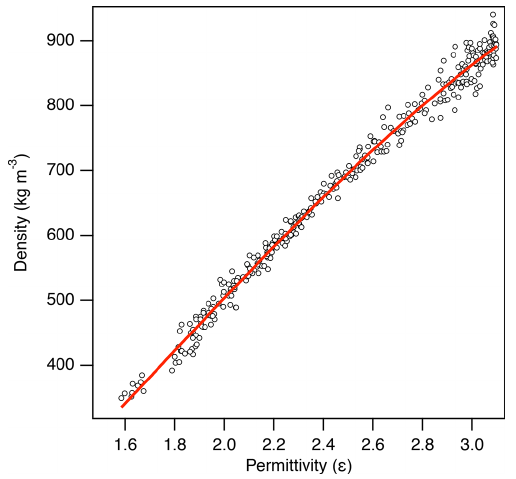
Figure A1. Scatter plot of the permittivity and bulk density and its third-order polynomial fitting curve ( ρ = − 20 . 15 ε 3 243 . 02 ε h − 220 . 57, where ρ is density and ε h is permittivity).